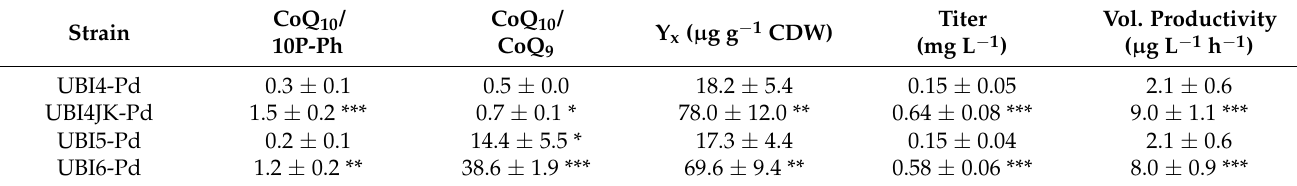
Titer Vol. Productivity (mg L − 1 ) ( µ g L − 1 h − 1 )